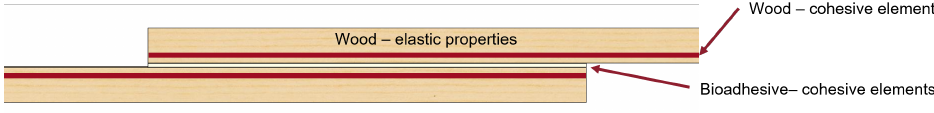
Figure 24. Illustration of the numerical